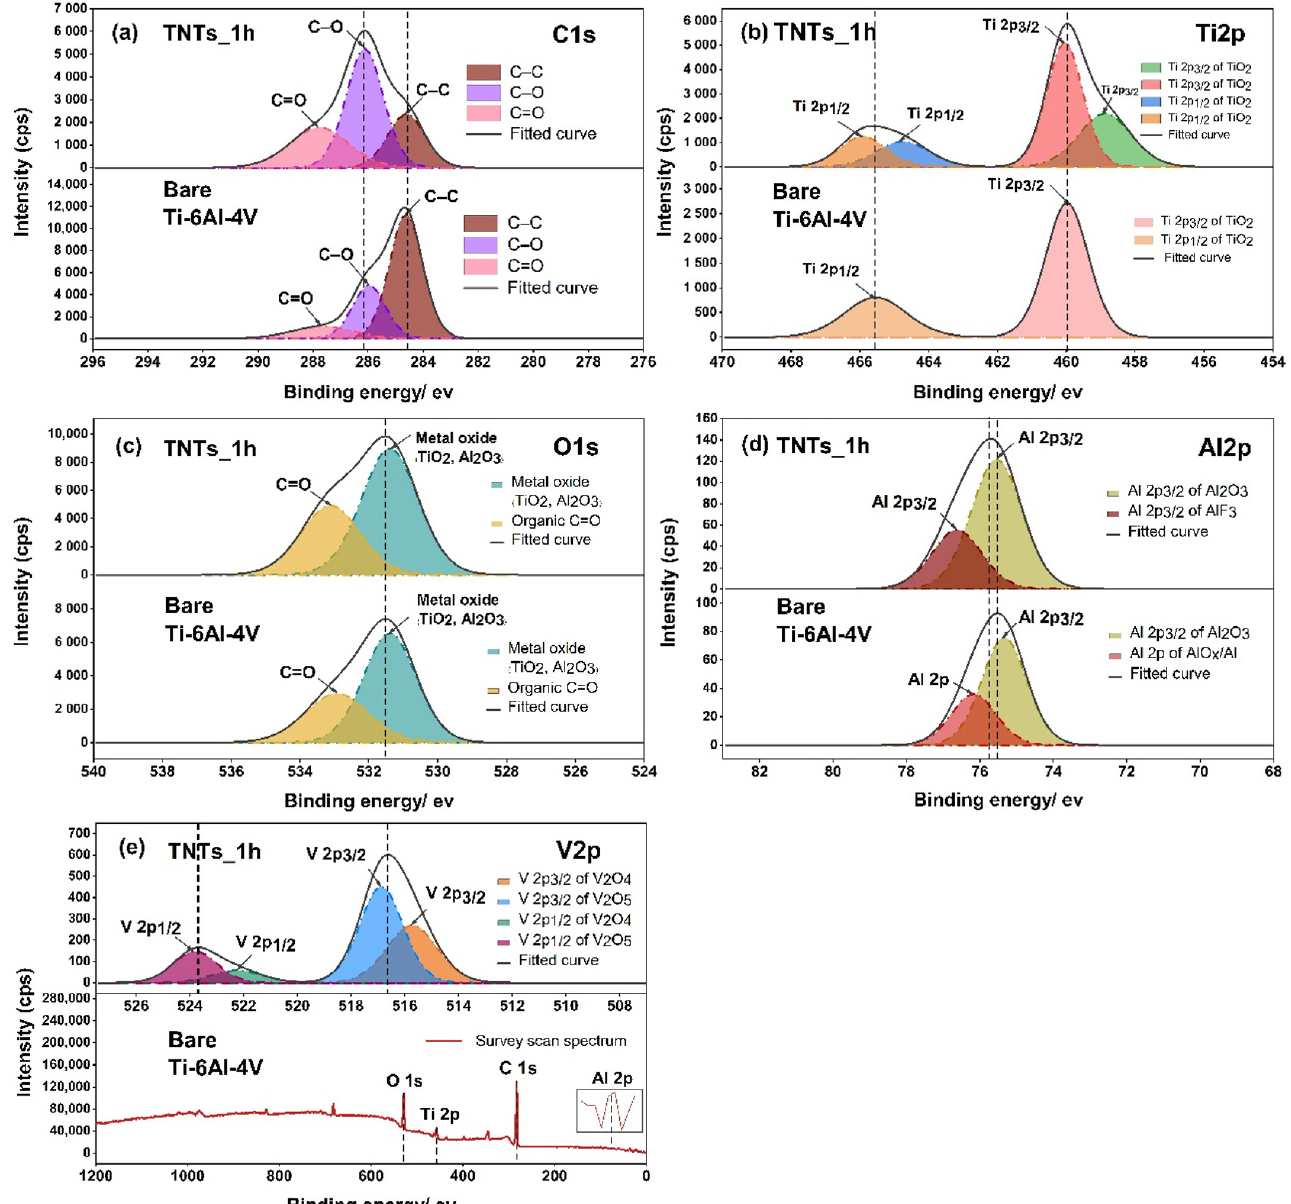
Figure 6. The XPS spectrums presenting the chemical composition of the oxide species of pre-post anodization process on the printed Ti-6Al-4V surface and the nanotubes of ( a ) C1s, ( b ) Ti2p, ( c ) O1s, ( d ) Al2p and ( e ) V2p, and the survey scan spectra for V2p.